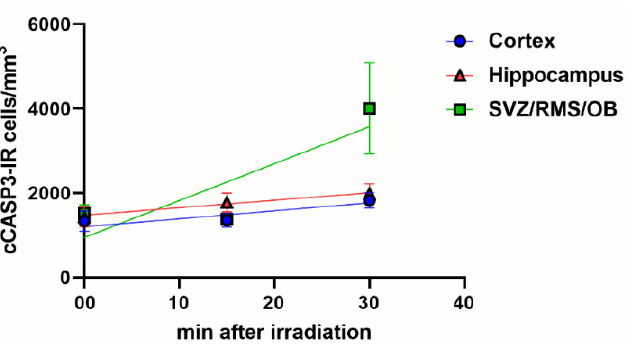
Figure 9. Linear regression curves of the volumetric density of cCASP3 immunoreactive cells in the cerebral cortex, hippocampus, and SVZ/RMS/OB in the function of the time of survival after X-ray irradiation. Note the different rates of response to X-rays in the SVZ/RMS/OB. Bars are 95% CI.